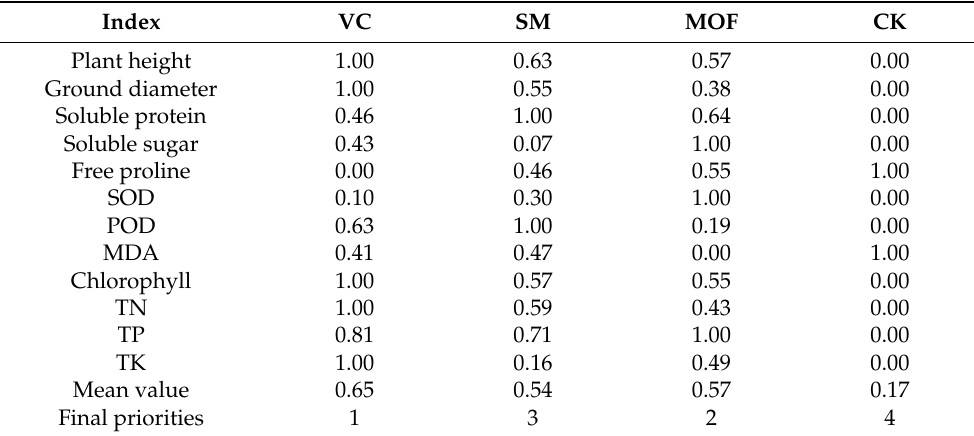
Table 4. Analysis of the subordination degree of physiological effects of “Qi-Nan” agarwood seedlings treated with different bio-organic fertilizer